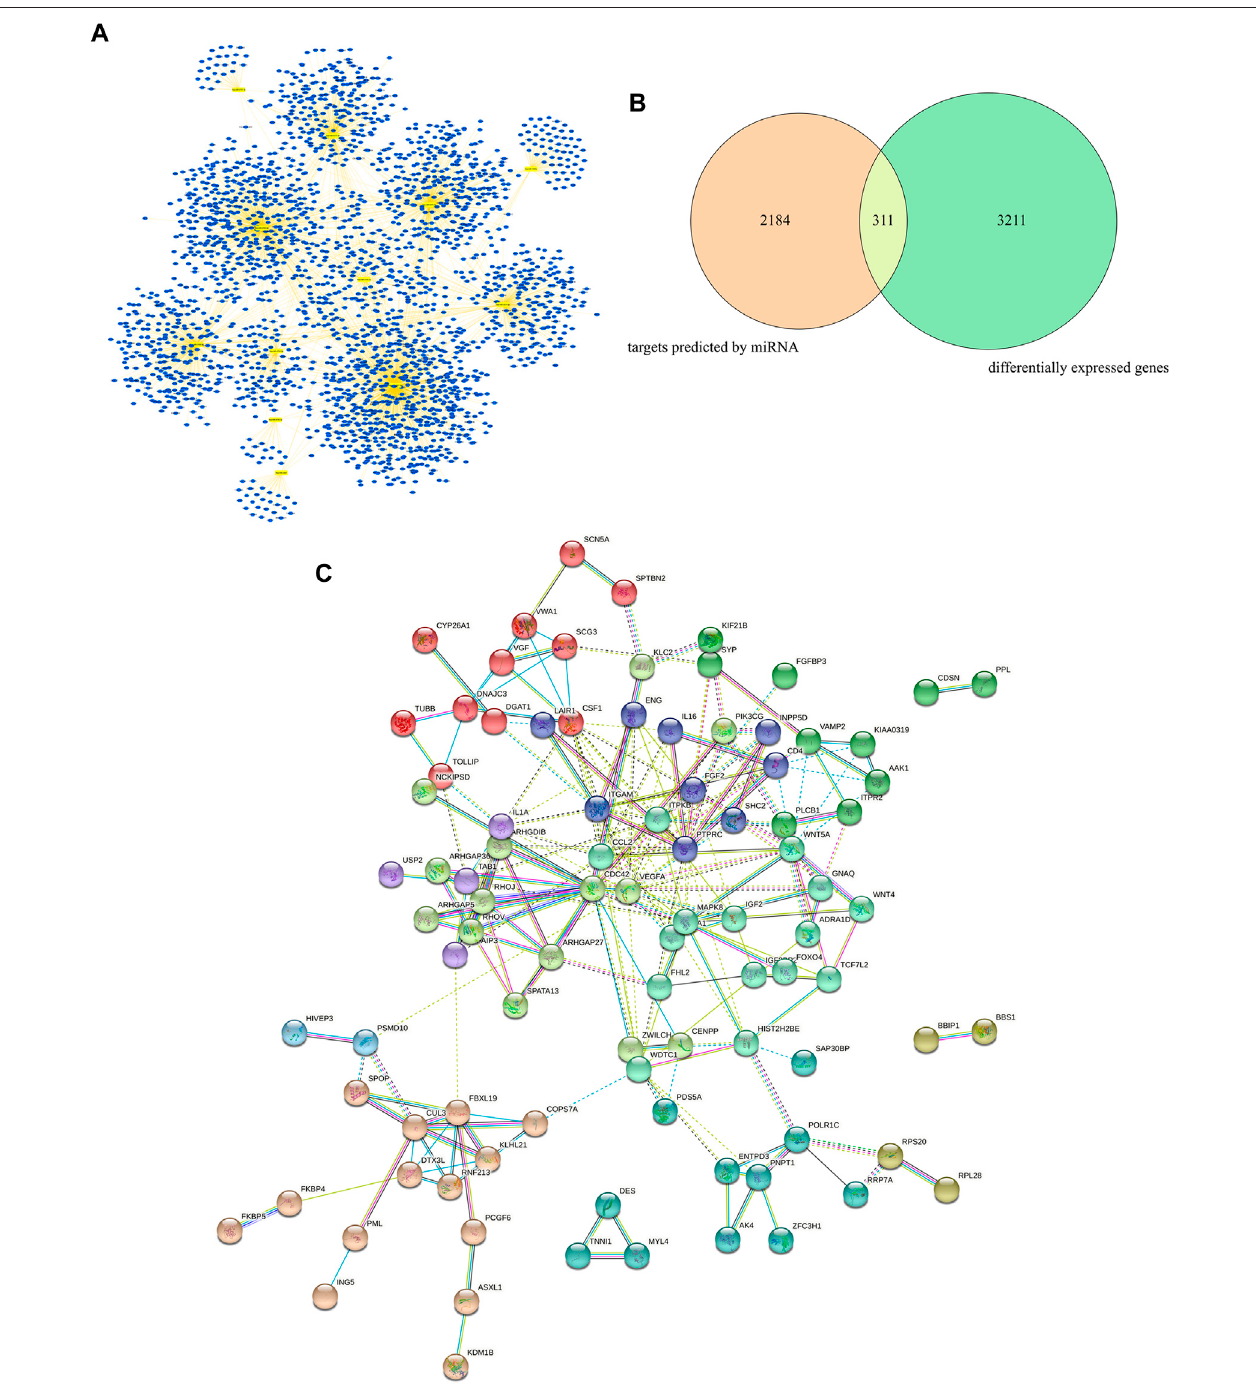
FIGURE 3 | Target prediction, core target analysis, and functional analysis of DEGs and DEMs in VaD. (A) miRNA-gene regulatory network of the 12 most dysregulated DEMs and their predicted target genes. (B) Venn diagram of the intersection between miRNA-predicted targets and DEGs. (C) Protein-protein interaction analysis of 94 core targets using